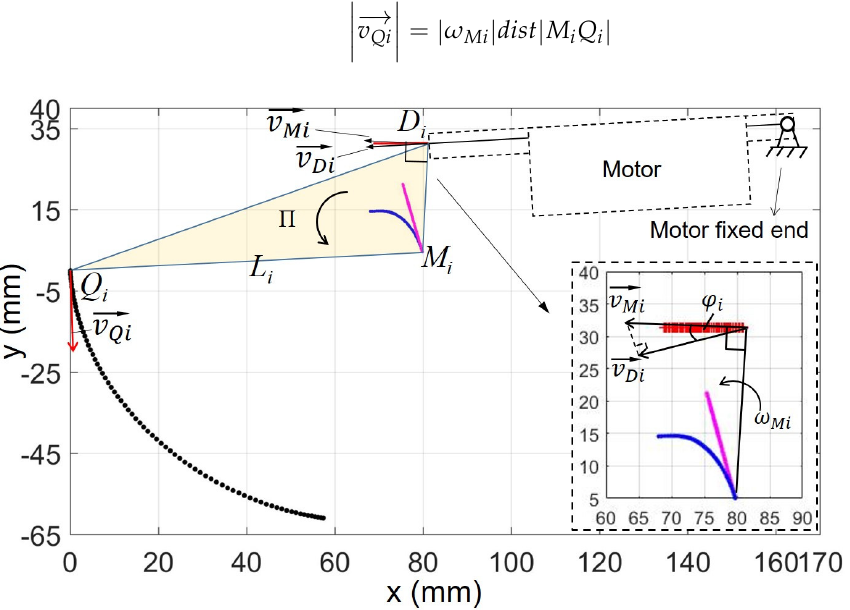
Figure 10. Relationship between the driving velocity and the output velocity.